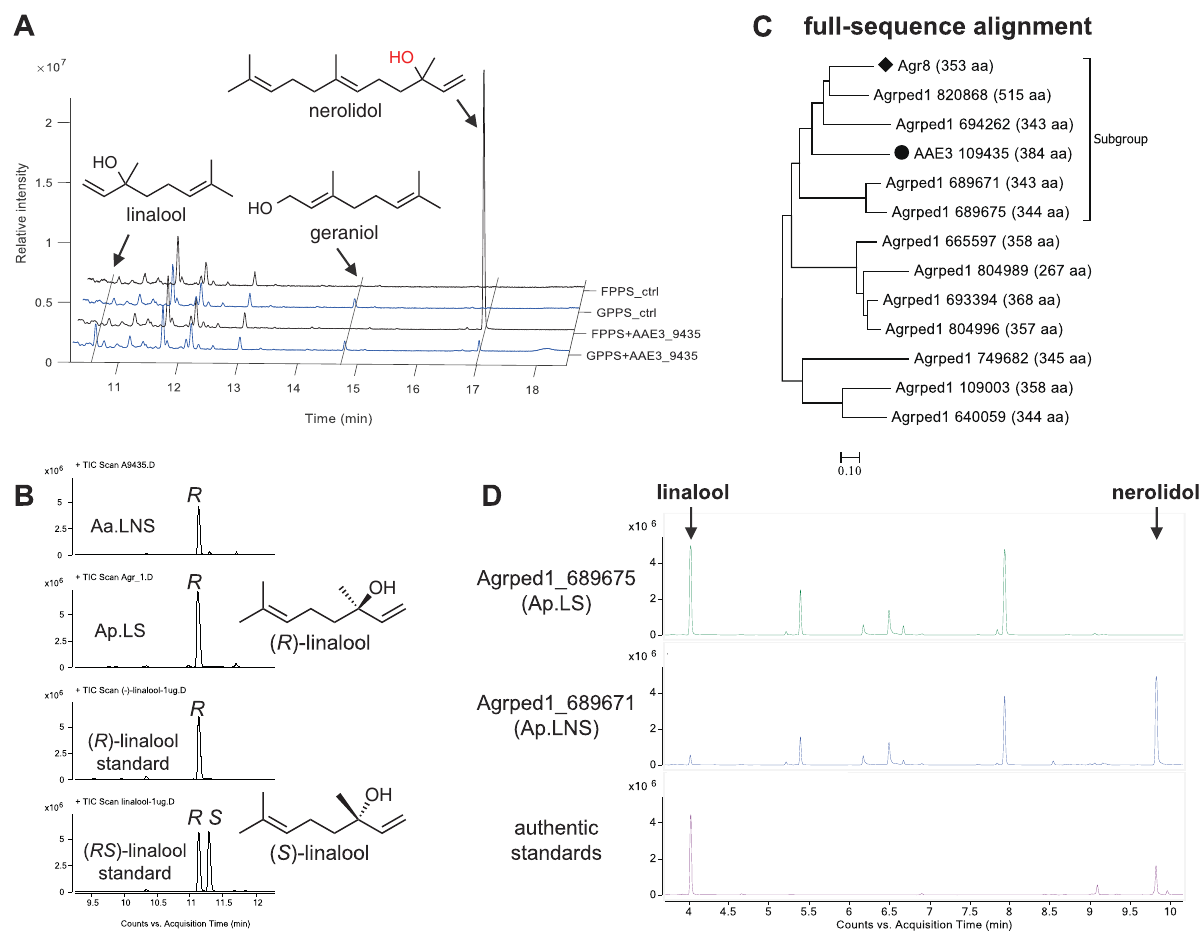
Fig. 2 Characterization of fungal linalool and nerolidol synthases (LNSs) and a fungal linalool synthase in E. coli . A GC-MS chromatograms of cultural supernatants of strains GPPS + 9435, FPPS + 9435 (co-expressing AAE3_109435 and GPP or FPP synthase), and the control strains GPPS_ctrl and FPPS_ctrl (expressing only GPP or FPP synthase). B Chiral separation of linalool produced by Aa.LNS and Ap.LS (Agrped1_689675) expressing strains. C Phylogenetic tree based on full-sequence alignment of Aa.LNS and terpene synthases (TPSs) in A. pediades . AAE3_109435 (a LNS) is marked with black circles ( ● ), Agr8 (a γ -muurolene/ β -cadinene synthase) with black diamonds ( ◆ ). D GC-MS chromatograms of the supernatant of E. coli clones